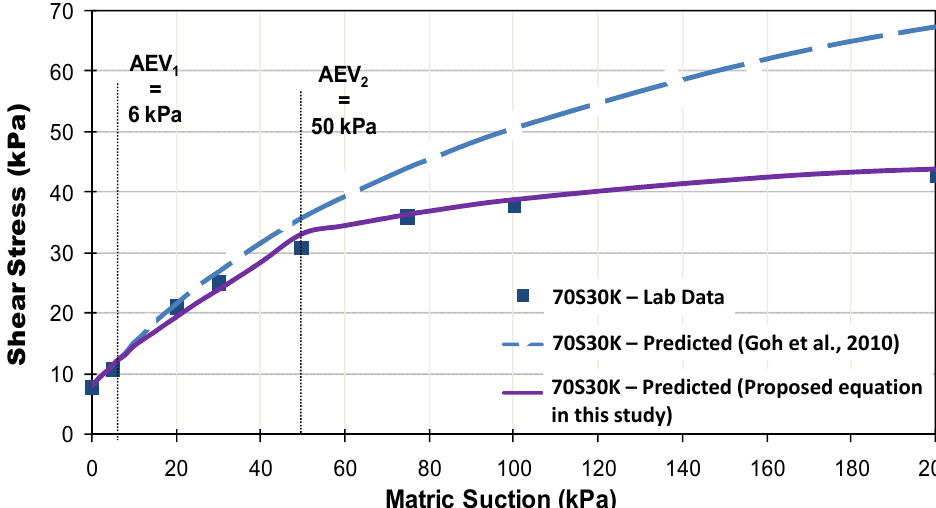
Figure 12. Comparison between Goh et al. [44] and the proposed equation in this study for predicting shear strength of 70S30K.